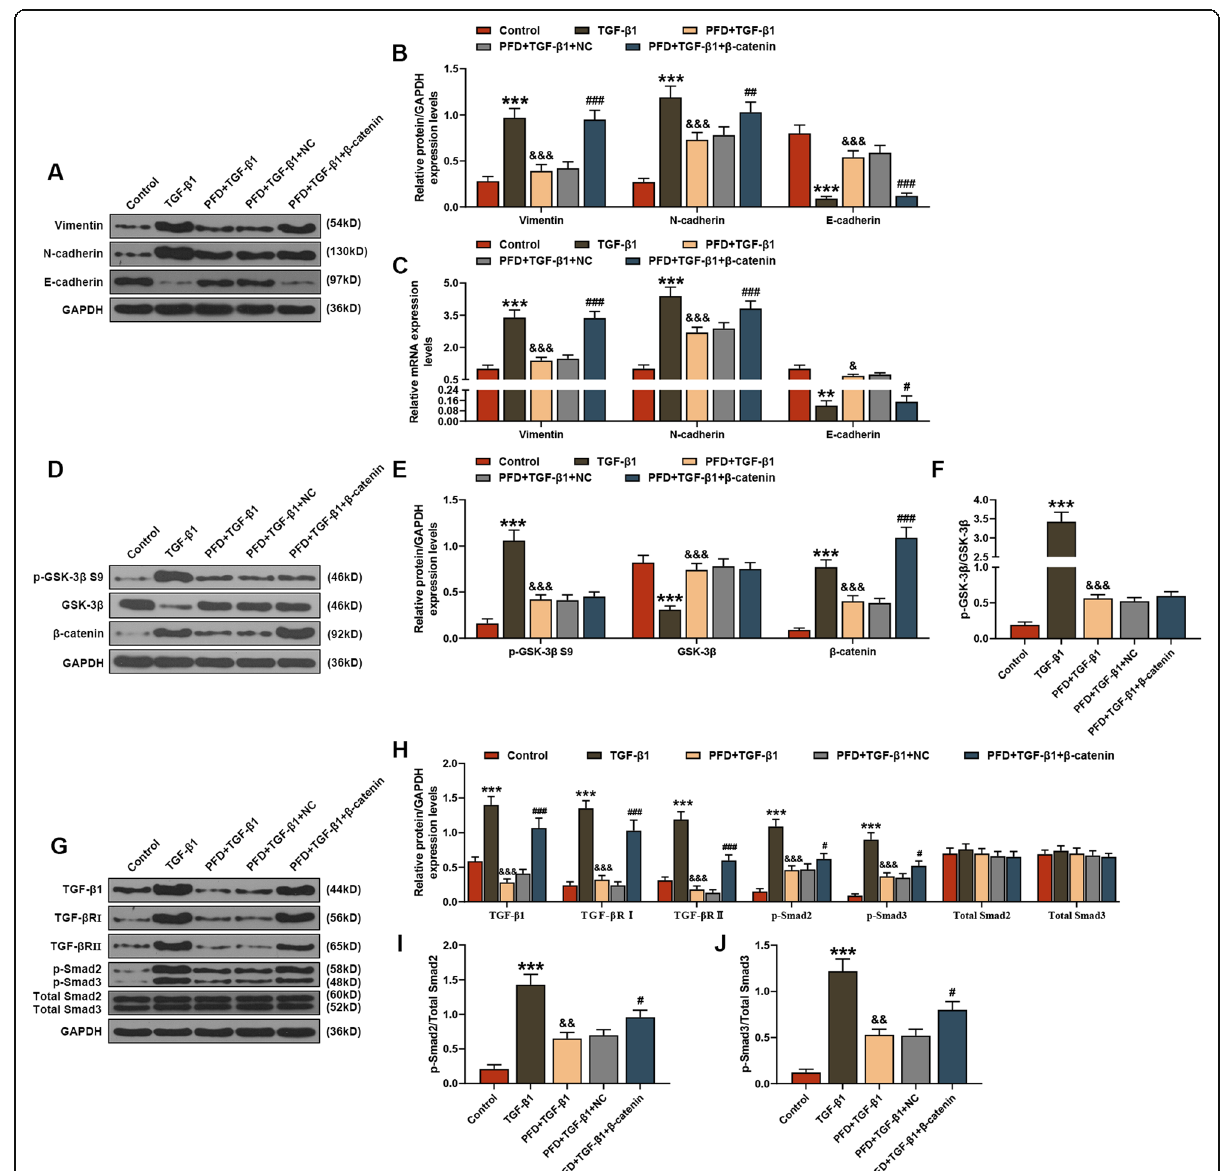
Fig. 4 Pirfenidone (PFD) protected human fetal lung fibroblasts (HLFs) from TGF- β 1 damage via Wnt/GSK-3 β / β -catenin and TGF- β 1/Smad2/3 signaling pathways. In this figure, HLFs were divided into control, TGF- β 1, PFD + TGF- β 1, PFD + TGF- β 1 + NC and PFD + TGF- β 1 + β -catenin groups. The mRNA and protein levels of epithelial-mesenchymal transition (EMT)-related proteins (Vimentin, E-cadherin, N-cadherin) in HLFs were determined by ( a , b ) Western Blot (WB) and ( c ) quantitative real-time polymerase chain reaction (qRT-PCR) assays. The protein levels of factors related to ( d - f ) Wnt/GSK-3 β / β -catenin (p-GSK-3 β S9, β -catenin) and ( g - j ) TGF- β 1/Smad2/3 (TGF- β 1, TGF- β R Ι , TGF- β R ΙΙ , p-Smad2/3) signaling pathways were measured by WB assay. ** P < 0.01, *** P < 0.001, vs. control; & P < 0.05, && P < 0.01, &&& P < 0.001, vs. TGF- β 1; # P < 0.05, ## P < 0.01, ### P < 0.001, vs. PFD + TGF- β 1 + NC. N =